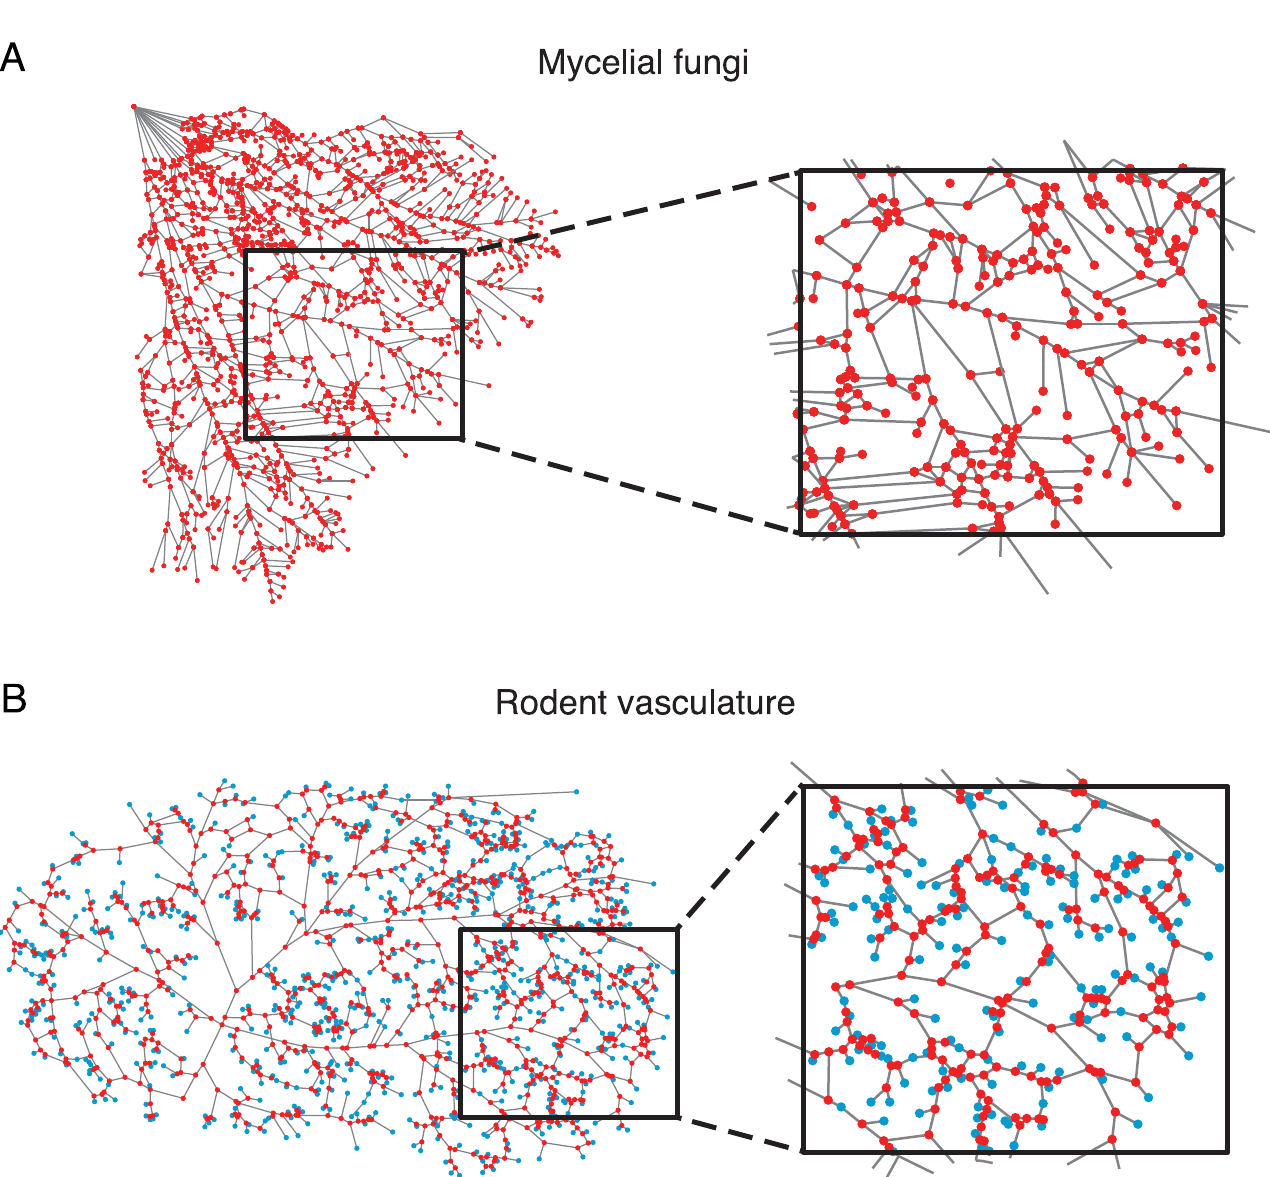
Fig 1. Distribution networks from mycelial fungi and rodent vasculature. (A) An example of a network from the fungus Phallus impudicus ( P.I. ). The cords making up the mycelial network are represented as edges (gray lines) and connect to form branching, fusion, or end points (red nodes). The top left node is the inoculum. (B) An example of a vasculature network from the surface of a rat brain in the region of the middle cerebral artery. Vessel segments are represented as edges (gray lines) and connect to form branching points on the surface backbone (red nodes) or connect to penetrating arterioles (blue nodes). In both (A) and (B) ,the figures on the right are magnified sections of the full